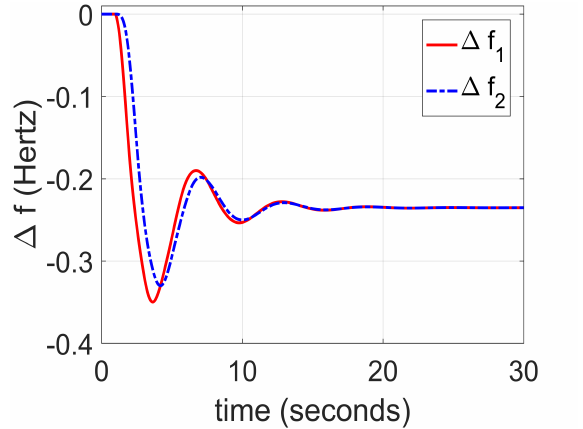
Figure 3. Frequency measurement under data integrity